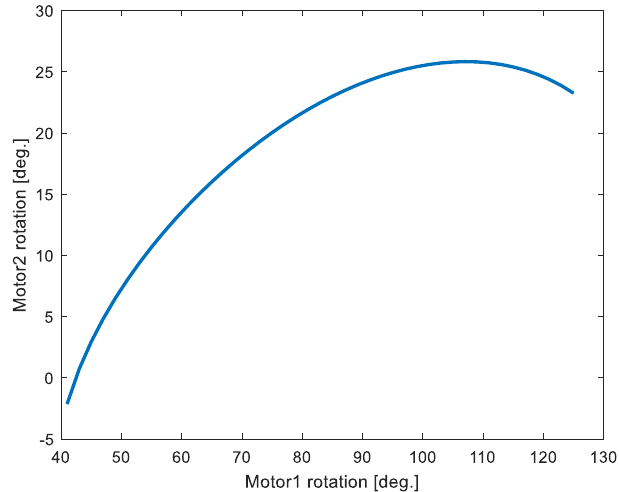
Figure 11. Angular correspondence of simultaneous operation of drive motors.